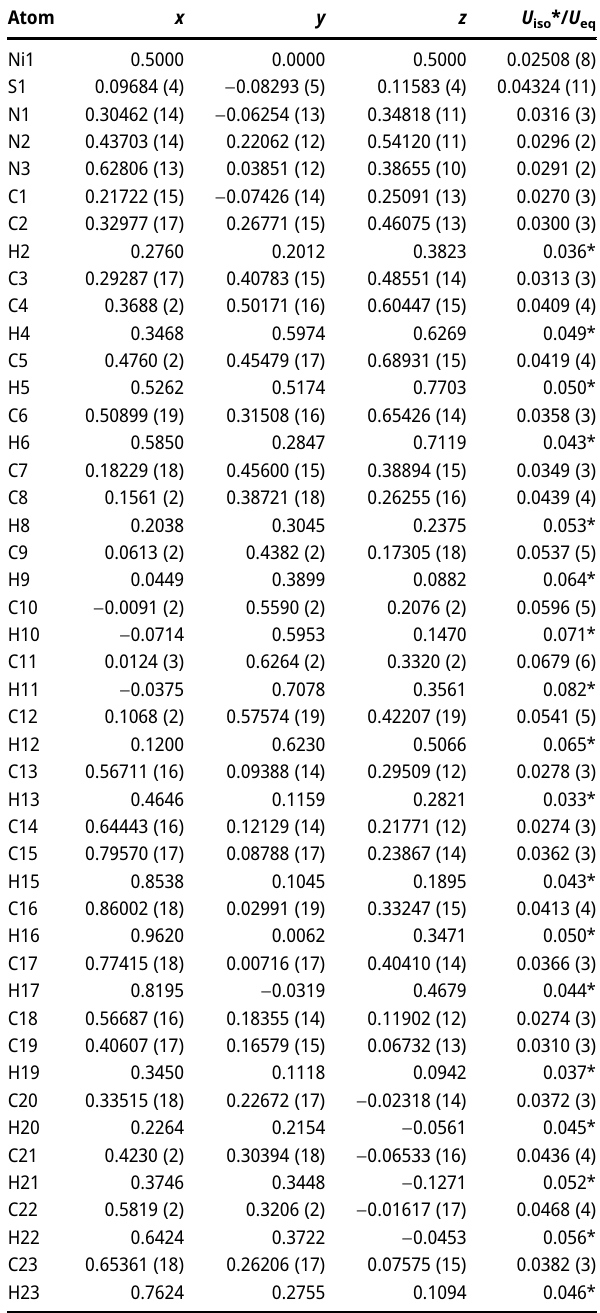
Table  : Fractional atomic coordinates and isotropic or equivalent isotropic displacement parameters (Å 